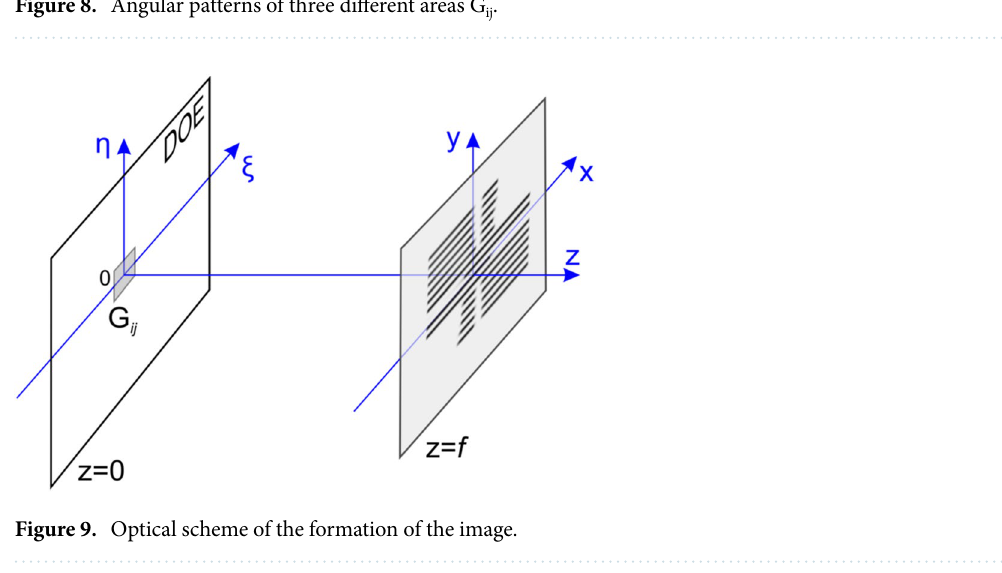
Figure 8. Angular patterns of three different areas G ij .